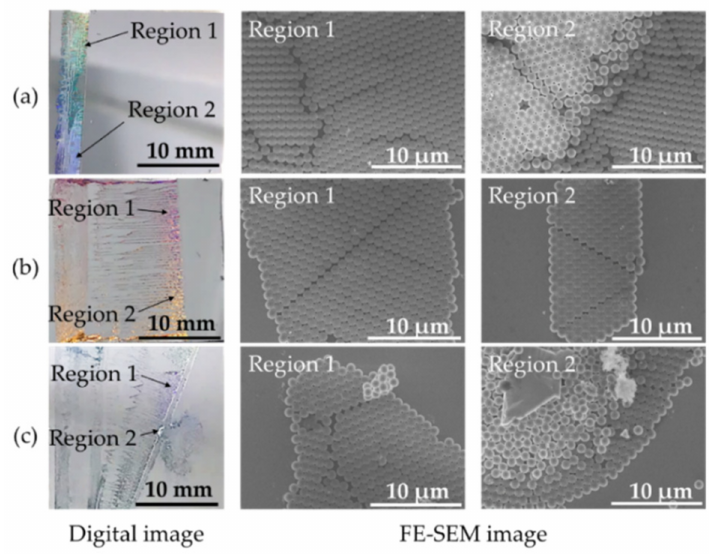
Figure 4. Digital images and FE-SEM images of the as-prepared PS films at two regions. Grown with different deposition speeds: ( a ) 1, ( b ) 5, and ( c ) 9 µ m/s.